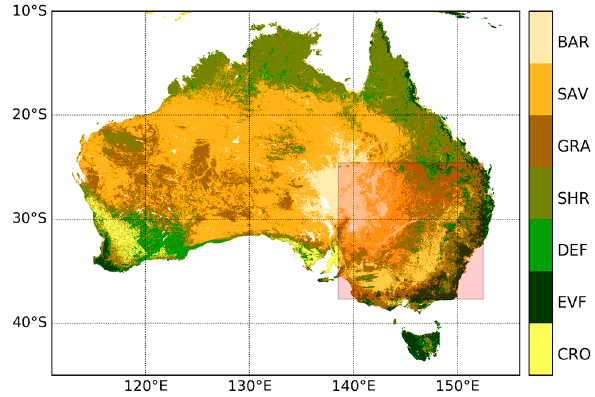
Figure 1. European Space Agency Climate Change Initiative (ESA CCI) land cover type map for Australia divided into bare areas (BAR), savannas (SAV), grasslands (GRS), shrublands (SHR), deciduous forest (DEF), evergreen forest (EVF), and croplands (CRO). The area with light red color denotes the extent of Murray–Darling